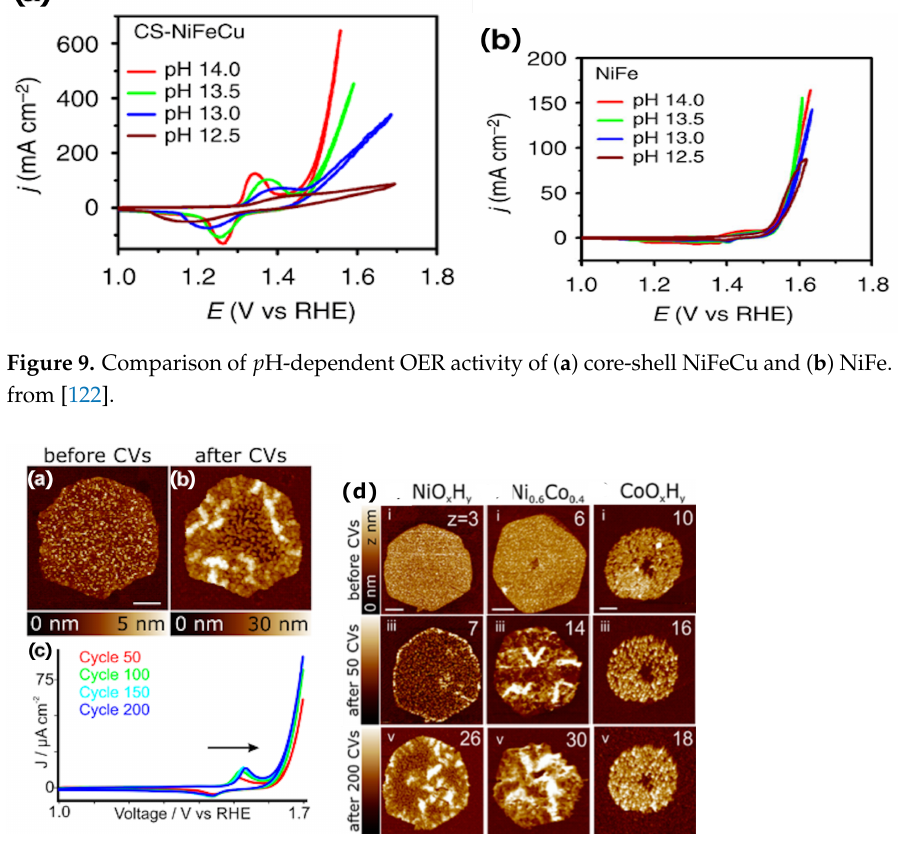
Figure 10. AFM topographical image of Ni 0.8 Fe 0.2 O x H x ( a ) before cyclic voltammetry ( b ) and after 200 cycles. ( c ) Cyclic voltammograms of Ni 0.8 Fe 0.2 O x H x at each stage. ( d ) AFM topographical images of NiCoO x H y nanosheets with different compositions before cyclic voltammetry, after 50 cycles and 200 cycles. Modified from